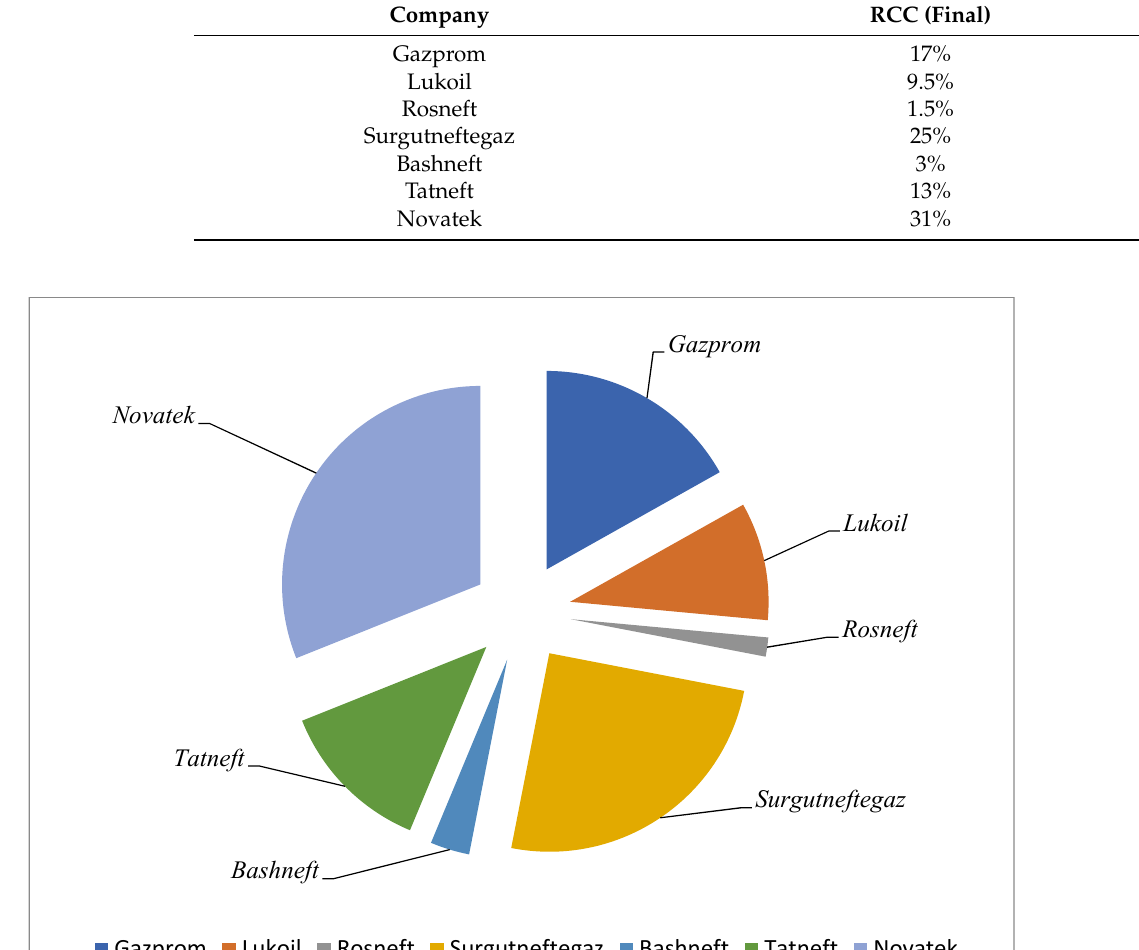
Figure 3. Structure of investments 2019 (optimal distribution in the structure of the investor’s portfolio on the basis of integral ranking on competitiveness in dynamics. Table 3. Integral rating RCC 2019.